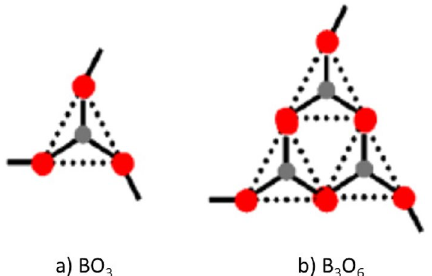
Figure 2. Different structural units of boron trioxide. ( a ) BO 3 triangles, ( b ) Boroxol